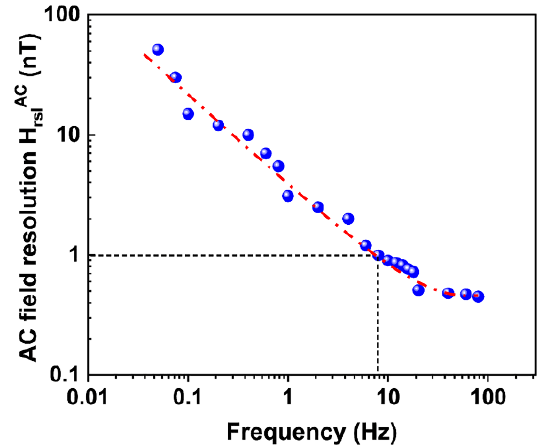
Figure 7. AC magnetic field resolution at ultralow frequencies (the dash-dot line is a guide for the eyes).